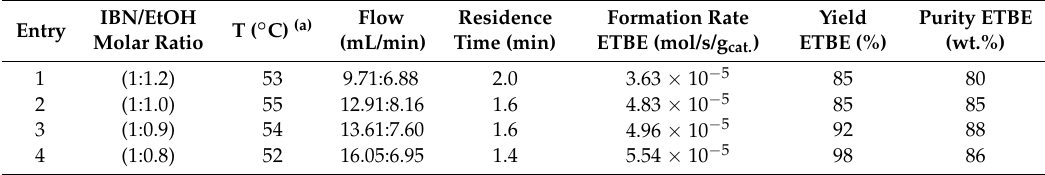
Table 2. Data set for the optimization of continuous processing for ETBE formation and increasing its final purity (process pressure 2.4 MPa, catalyst volume 33